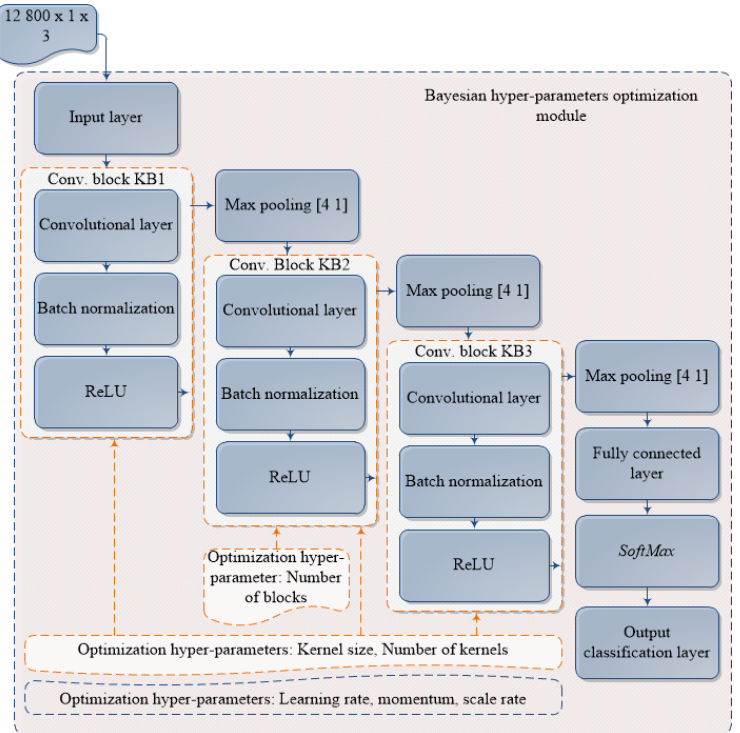
Figure 4. Model outline for hyper-parameters optimization of fault diagnosis CNN model using Bayesian optimization.